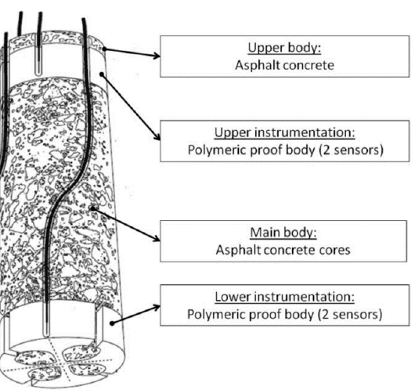
Figure 3. Laval University fiber-optic strain gauge (figure is reproduced from Bilodeau & Doré [31]).